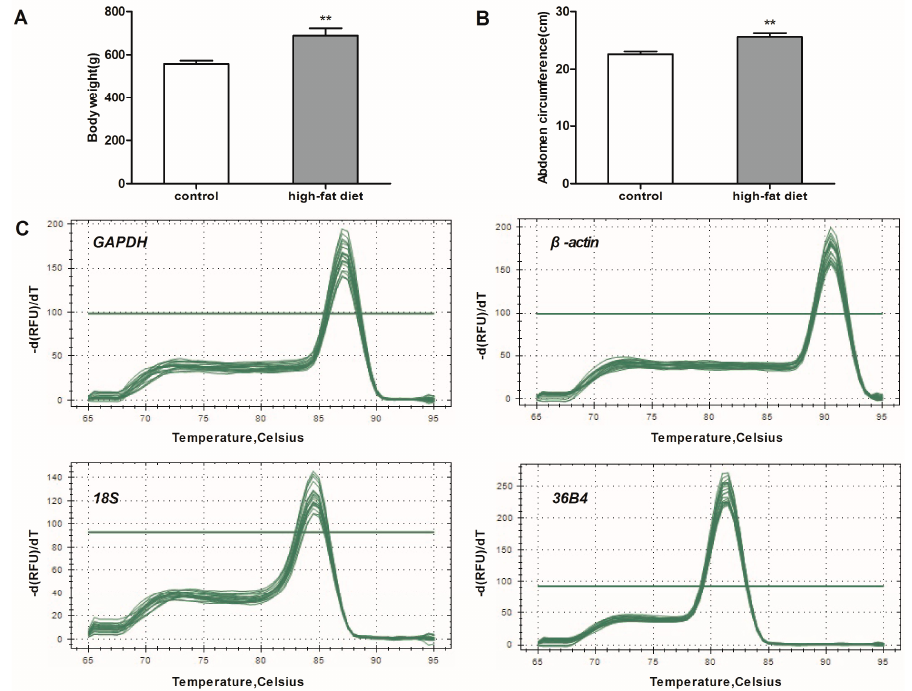
Figure 1. Body weight, abdominal circumference and melting curves for the quantitative real-time polymerase chain reaction (qRT-PCR) products. ( A ) body weight ( n = 6); ( B ) abdomen circumference ( n = 6); ( C ) melting curves for the qRT-PCR products. The single sharp peak represents a specific qRT-PCR product. GAPDH : Glyceraldehyde-3-phosphate dehydrogenase; 36B4 : acidic ribosomal phosphoprotein P0. ** p < 0.01 vs. control.